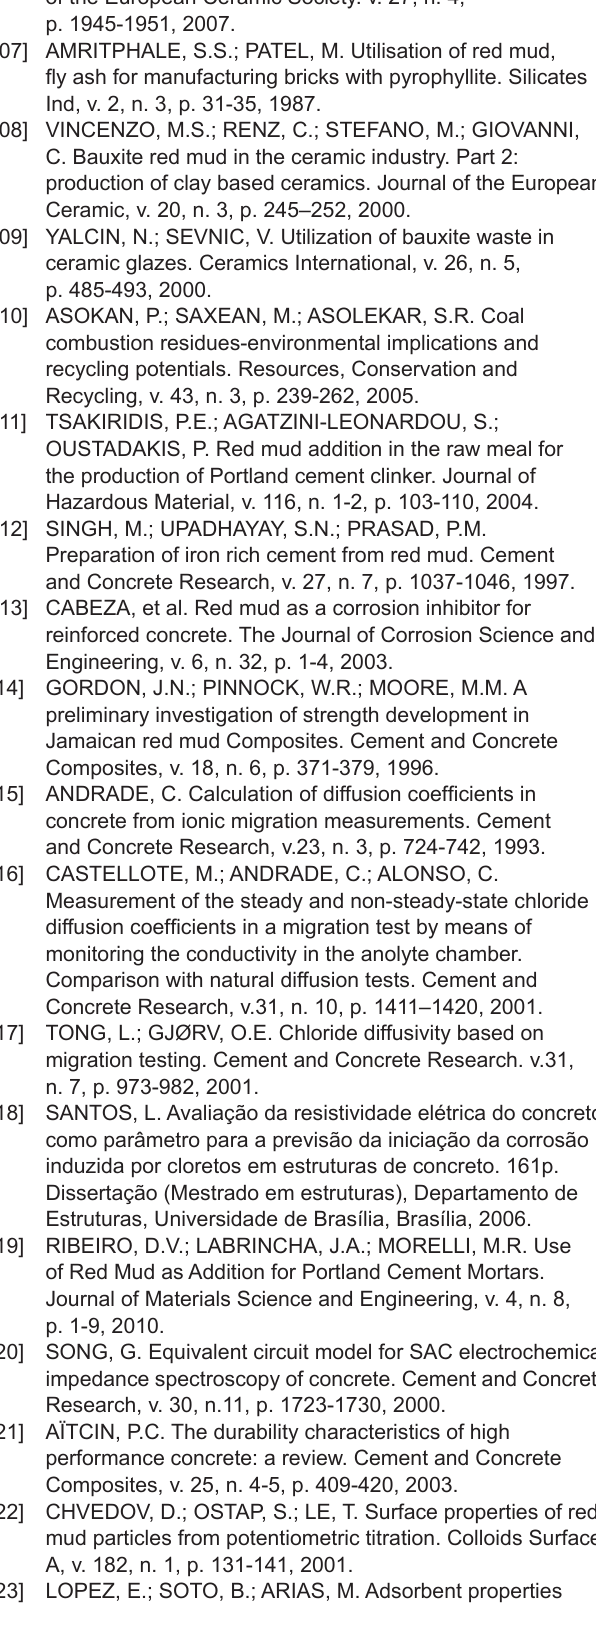
Figure 10 – Correlation